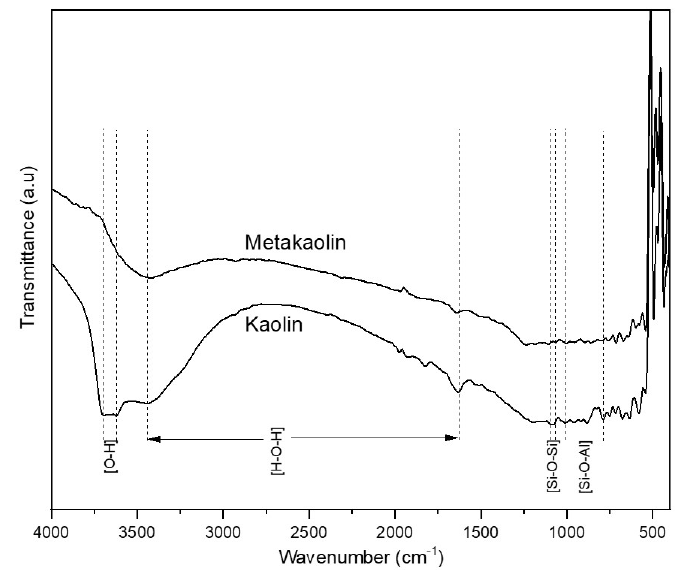
Figure 3. FT–IR spectra of kaolin and metakaolin.